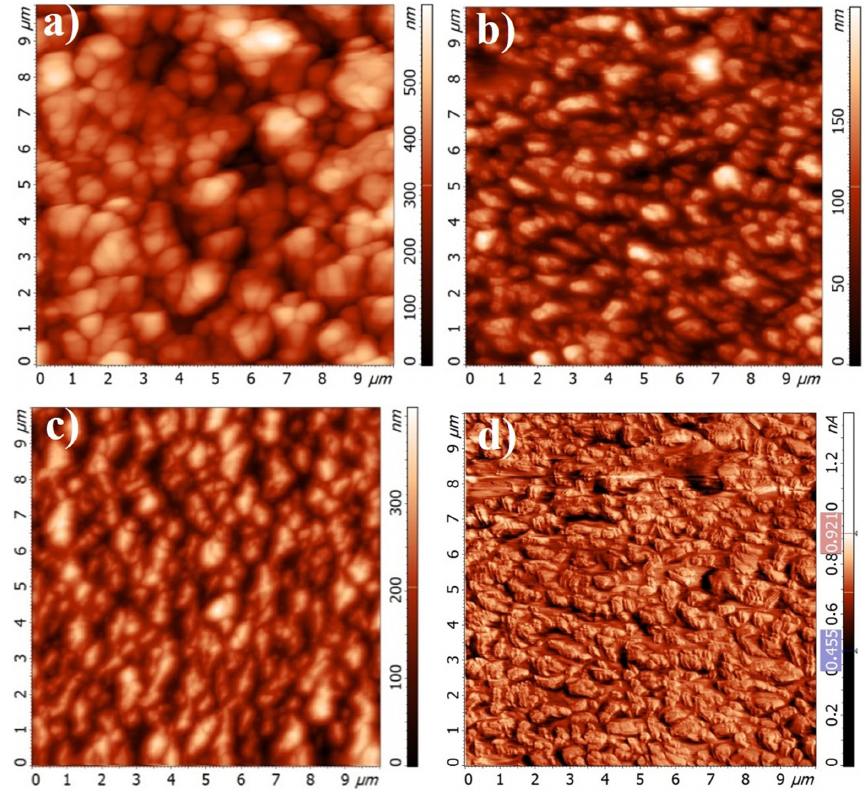
Figure 6. Atomic force microscopy (AFM) topography images of Cr-Al-C films on a Si (100) wafer at ( a ) 60 V; ( b ) 90 V; ( c ) and 120 V. ( d ) A lateral force map at 90 V.